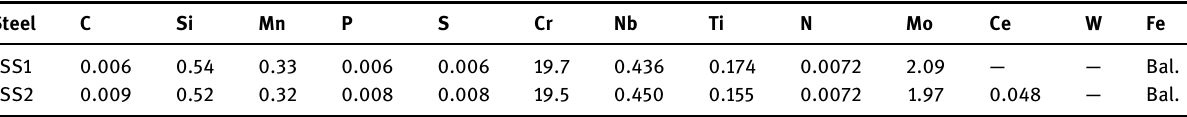
Table 1: Chemical compositions of ferritic stainless steel samples ( wt% )